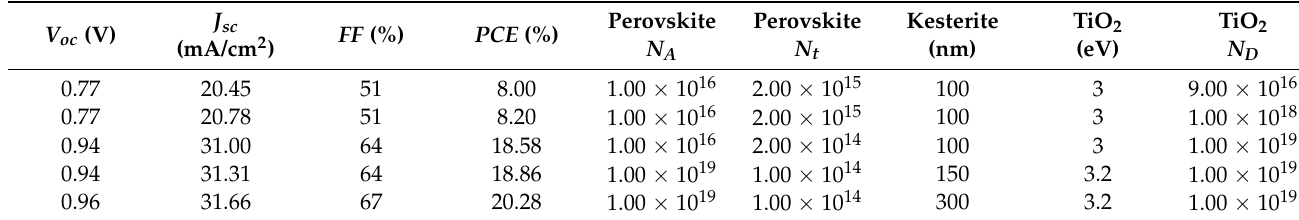
Table 4. History of parameters of the simulations obtained in the solar cells.